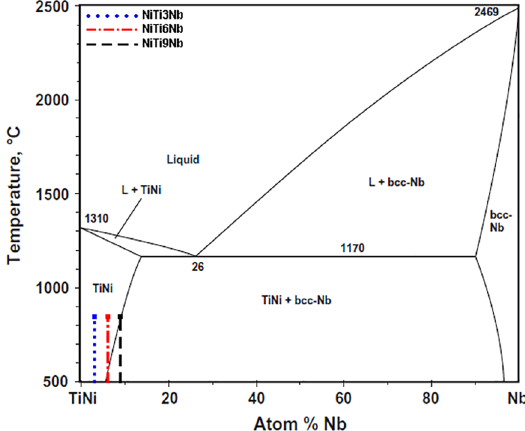
Figure 2. Phase diagram of the pseudo-binary “NiTi–Nb” system with studied compositions highlighted 3